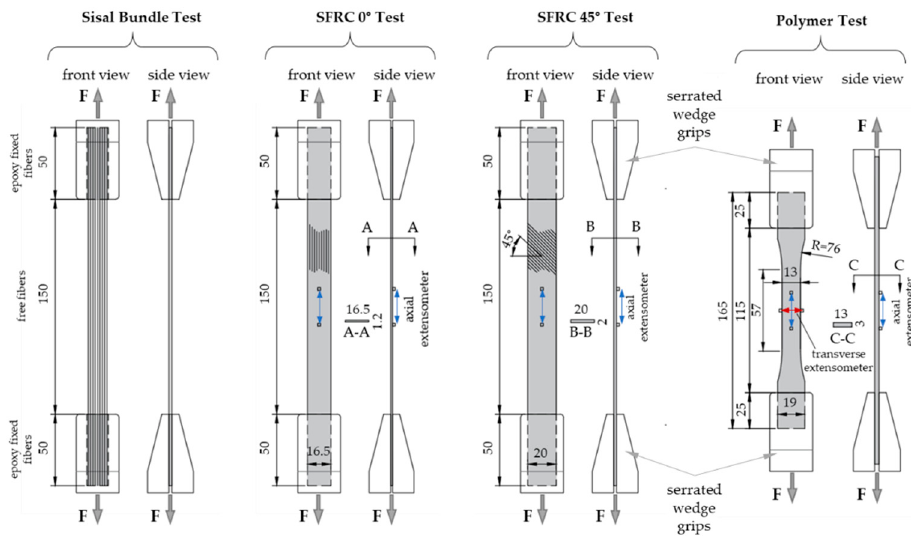
Figure 2. Schematic description of tensile tests for different specimens (dimensions in mm).